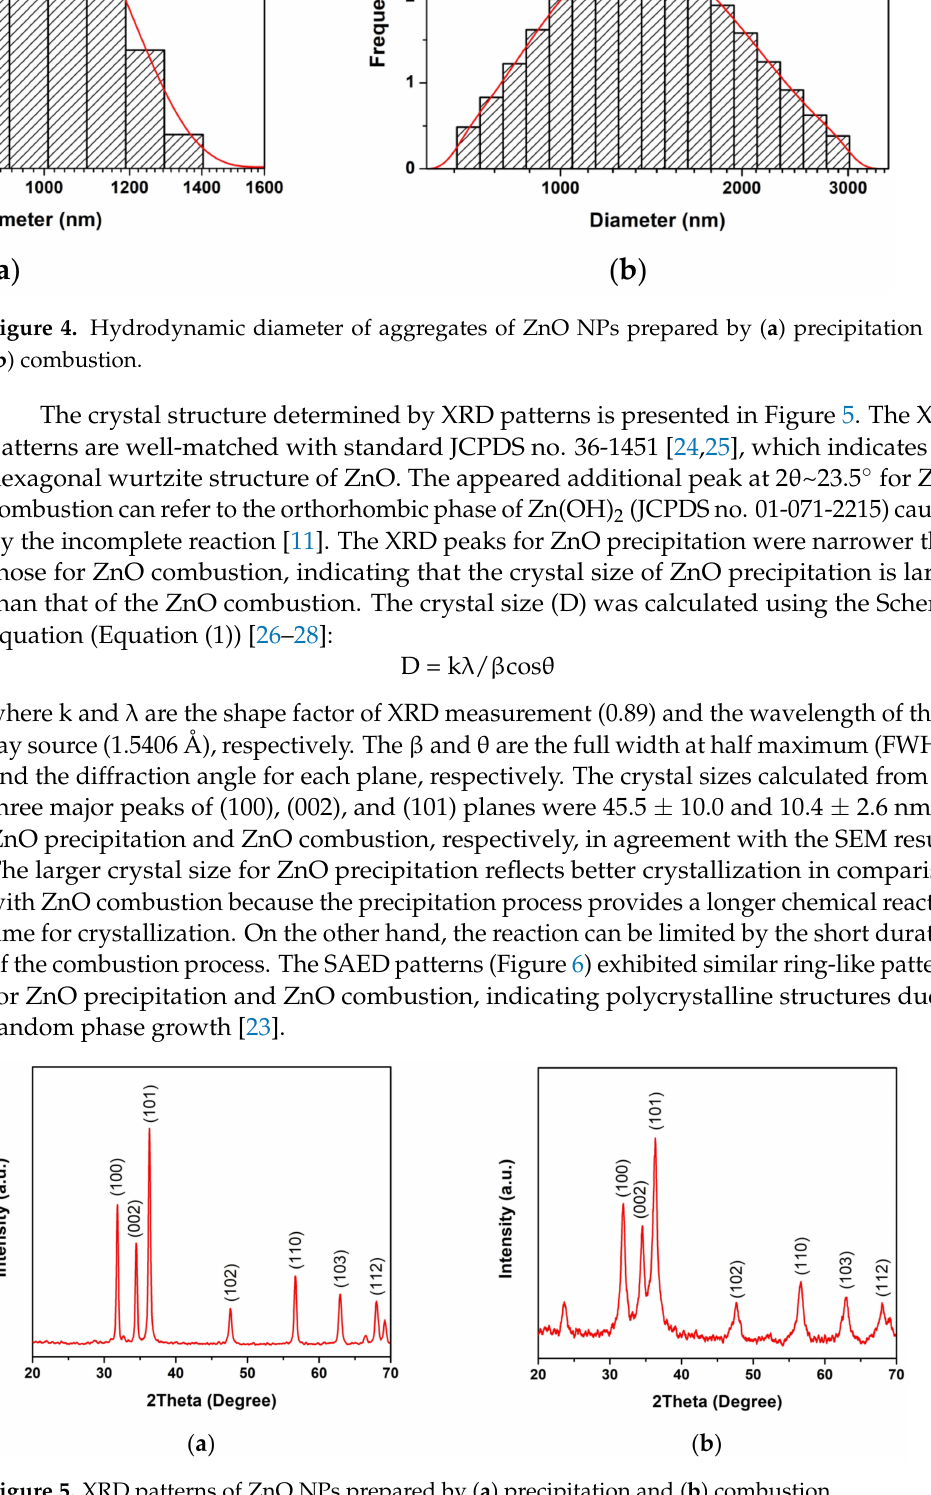
Figure 5. XRD patterns of ZnO NPs prepared by ( a ) precipitation and ( b )